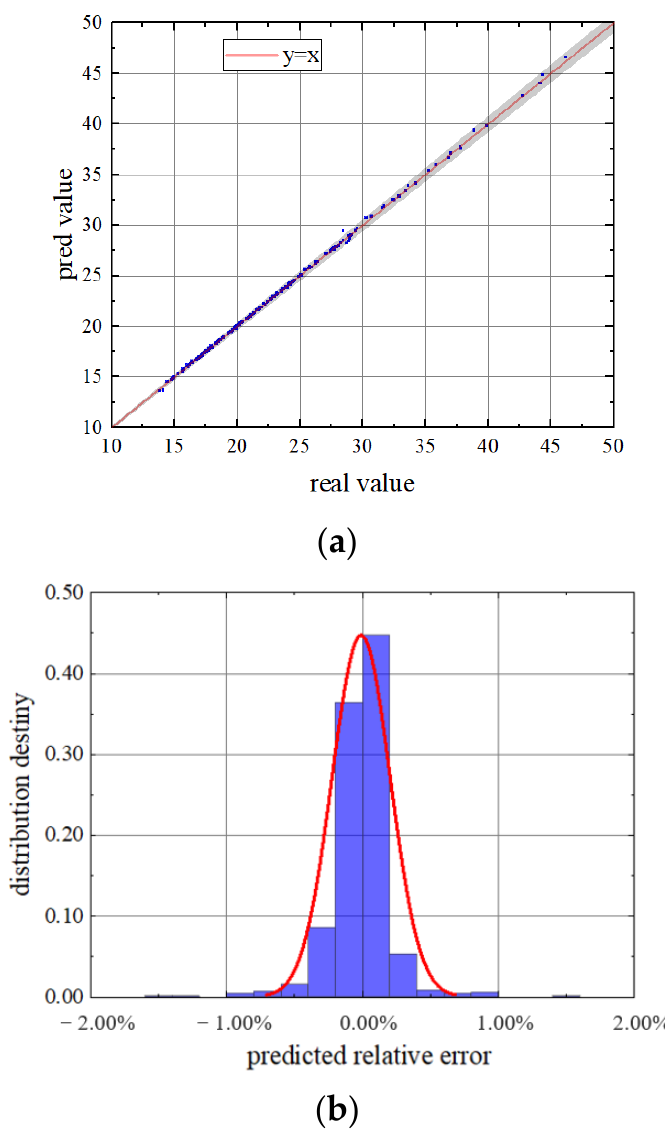
Figure 13. First order amplitude of tangential flow force (( a ) Predicted value and true value; ( b ) relative error density distribution).